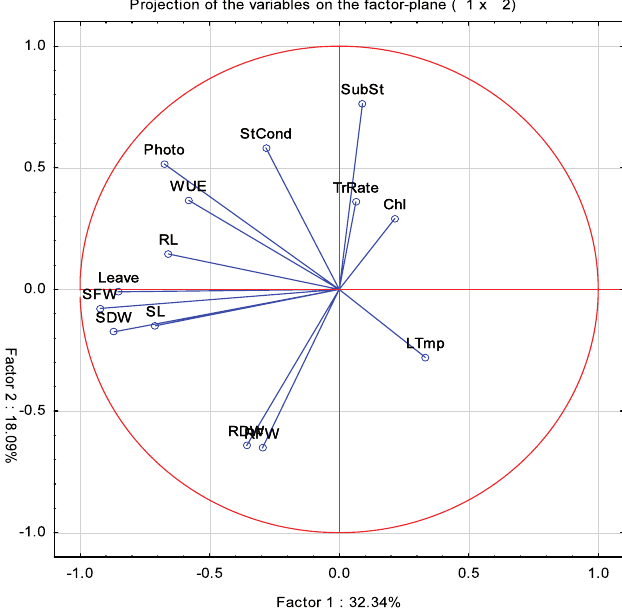
Fig. 1: Biplot graph of 54 genotypes under high temperature stress for various